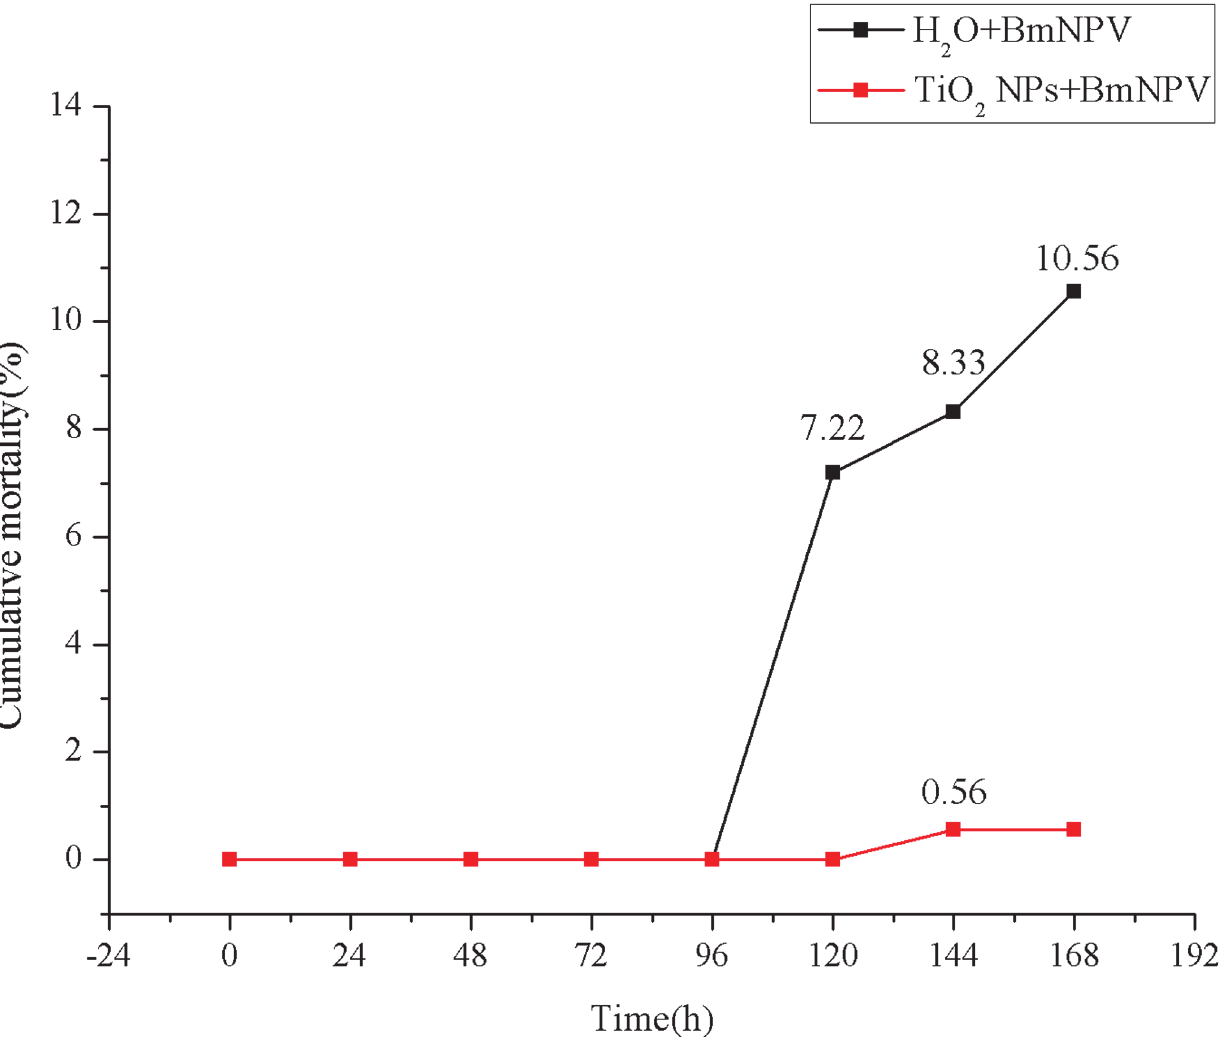
Fig 3. Cumulative incidence of BmNPV infection in silkworms. Black polylines represent the control group, and red polylines represent the experimental group. X-axis is the time after BmNPV infection, and Y-axis is the cumulative incidence (%).